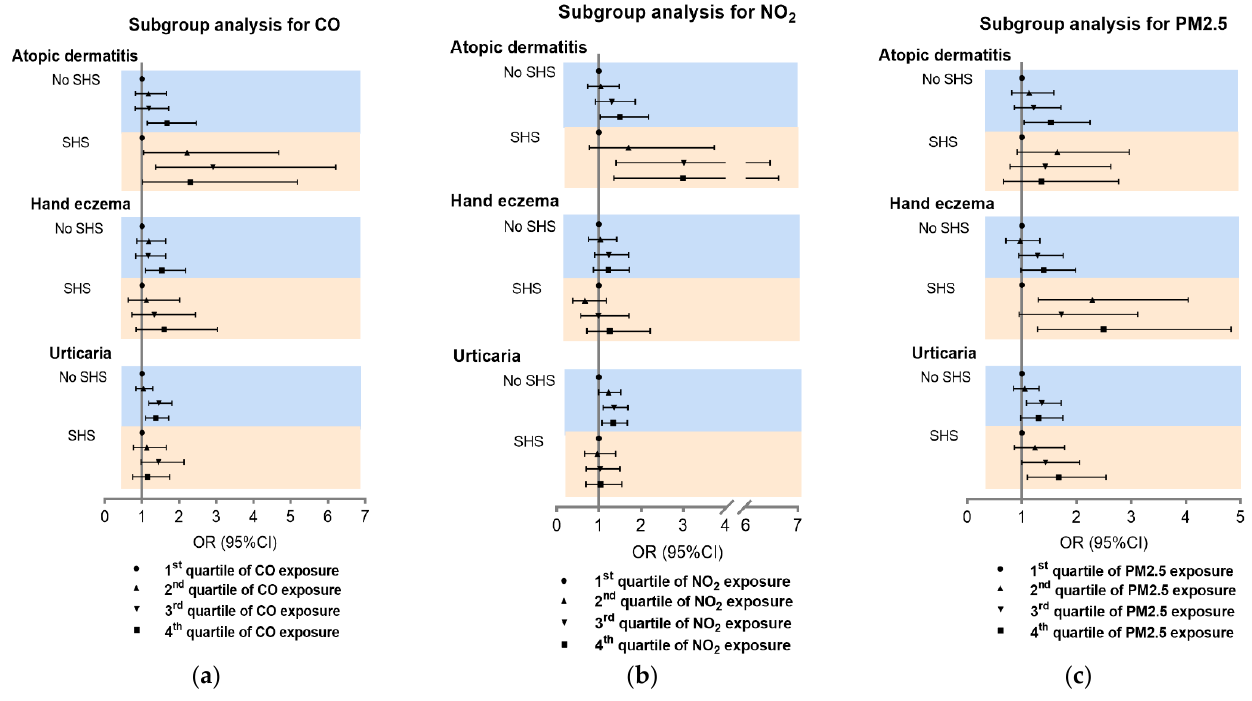
Figure 4. Subgroup analysis of association between CO, NO 2 , and PM 2.5 and inflammatory skin dis- eases. Subgroup analysis for CO ( a ), NO 2 ( b ) and PM 2.5 ( c ). SHS: second-hand smoke.